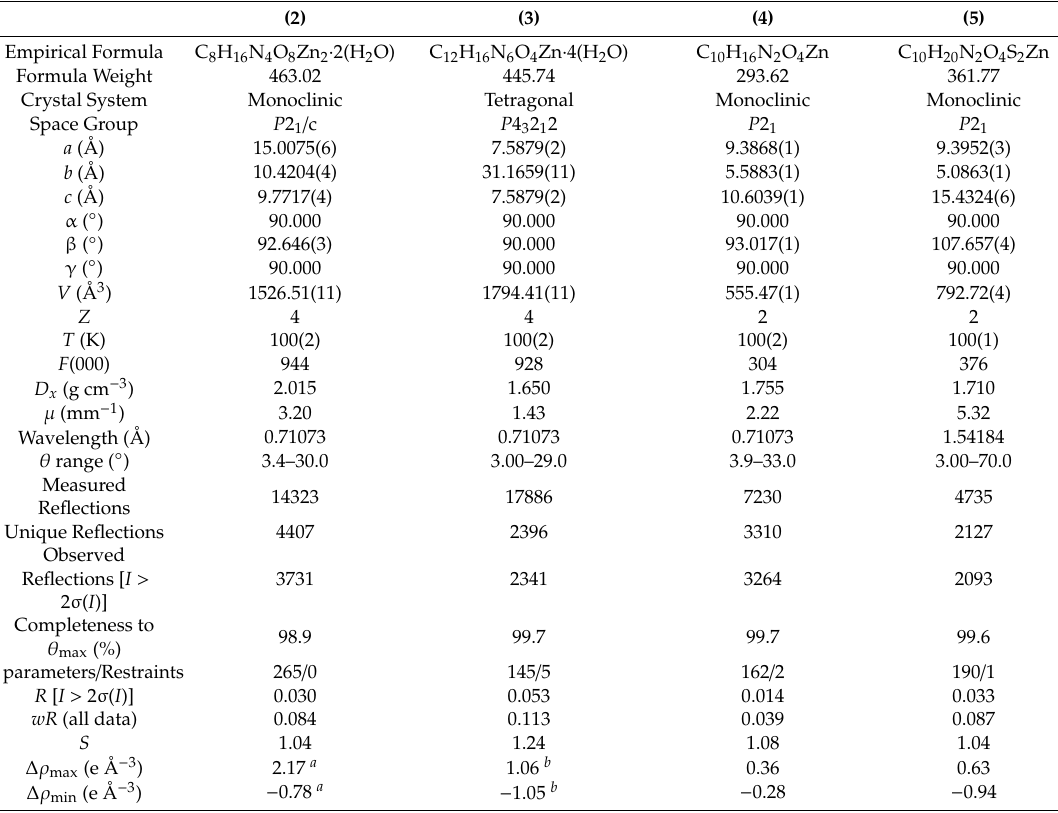
Table 1. Crystallographic data for complexes of Zn(II) with glycine ( 2 ), L-histidine ( 3 ), L-proline ( 4 ), and L-methionine ( 5